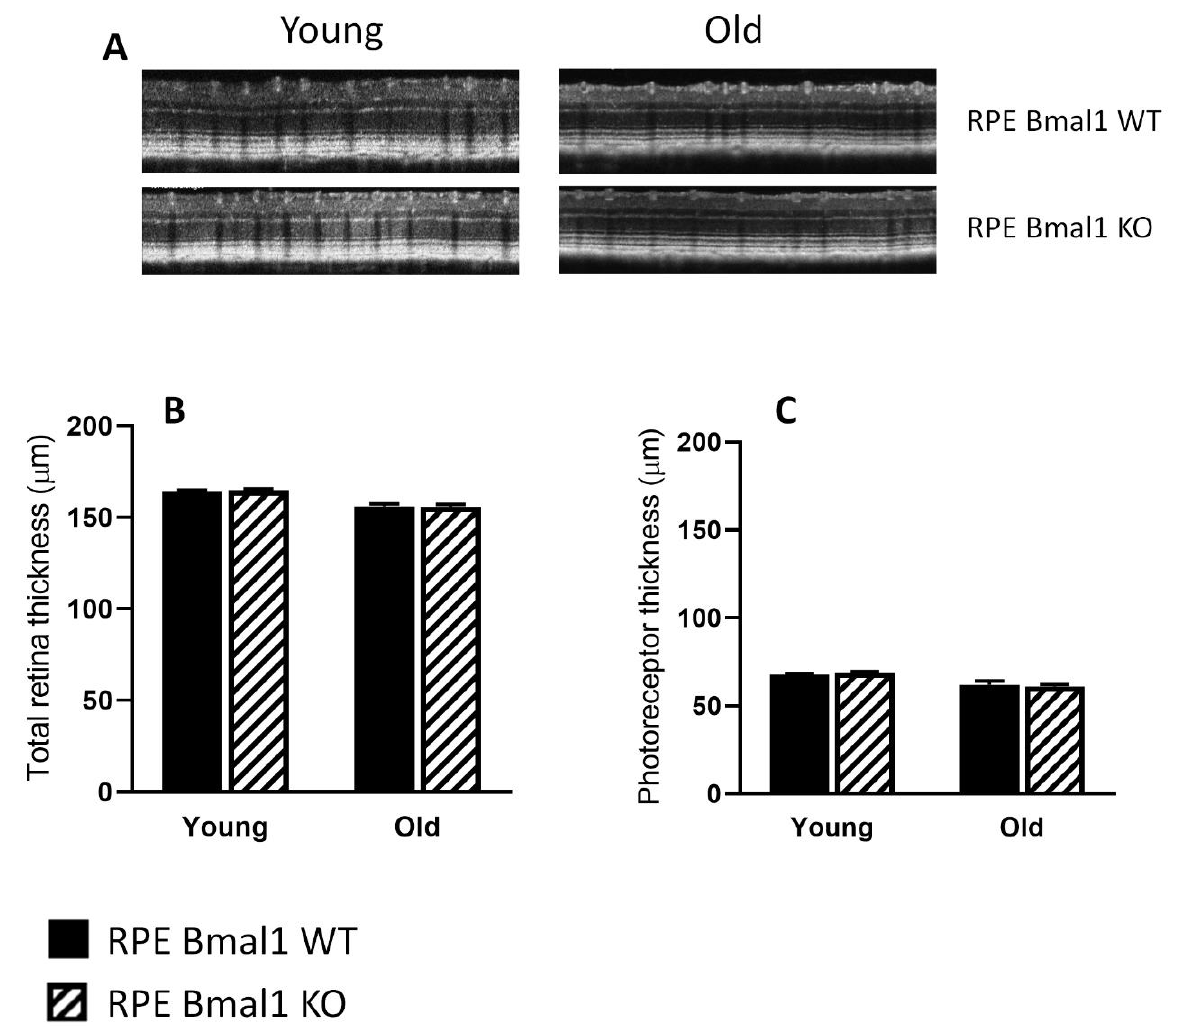
Figure 6. Retinal thickness is not affected by disruption of the RPE circadian clock. Retina thickness was assessed to determine if there were any age-related effects that could be observed with a circadian disruption in the RPE. Representative retinal images taken with SD-OCT from young and old RPE Bmal1 WT and RPE Bmal1 KO mice ( A ). Total retinal thickness was not affected in the RPE of mice lacking Bmal1 in the RPE at any age measured ( B ; p > 0.1, two-way ANOVA, Tukey post hoc, n = 4–6/group). No differences were observed in the thickness of the photoreceptor layer between the two genotypes at both ages ( C ; p > 0.1, two-way ANOVA, n = 4–6 mice/group). Data are expressed as mean ± SEM.